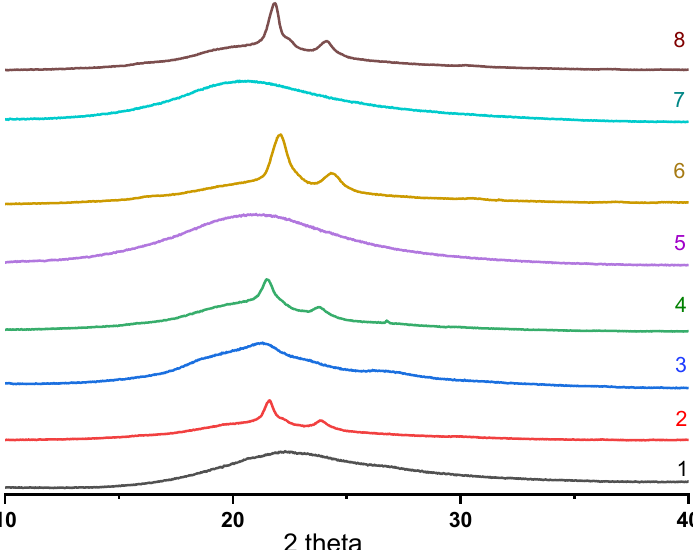
Figure 9. X ‐ ray diffraction patterns of segmented PUU: S1 ( 1 ), S2 ( 2 ), S3 ( 3 ), S4 ( 4 ), S5 ( 5 ), S6 ( 6 ), S7 ( 7 ), and S8 ( 8 ).